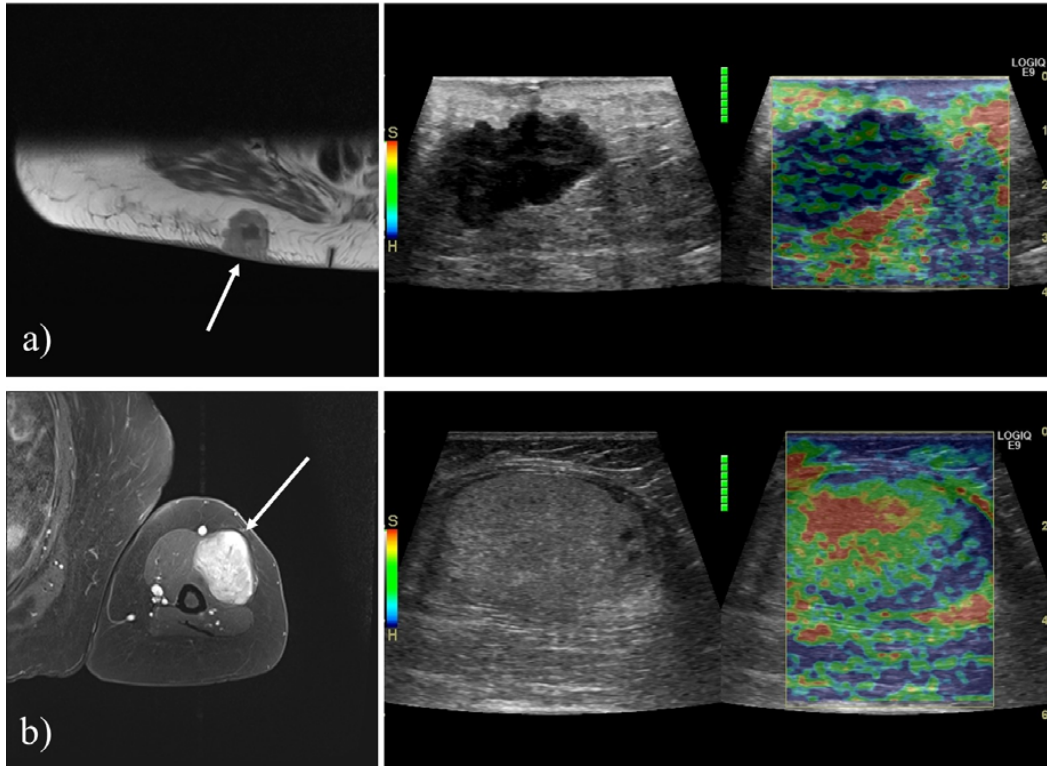
Figure 2. Examples of tumors included. ( a ) A 71 ‐ year ‐ old female with metastasis of malignant melanoma. T1 ‐ weighted transverse contrast ‐ enhanced MRI showing a lesion superficial to the right gluteal musculature. The tumor appeared hypoechoic and irregular on B ‐ mode US, and SE revealed the tumor to be hard (blue). ( b ) A 75 ‐ year ‐ old female with a chondroid lipoma. T1 ‐ weighted fat suppressed contrast enhanced MRI showing a tumor in the anterolateral upper arm. B ‐ mode US and strain elastography (SE) revealed the tumor to be isoechoic, homogenous and soft (red).